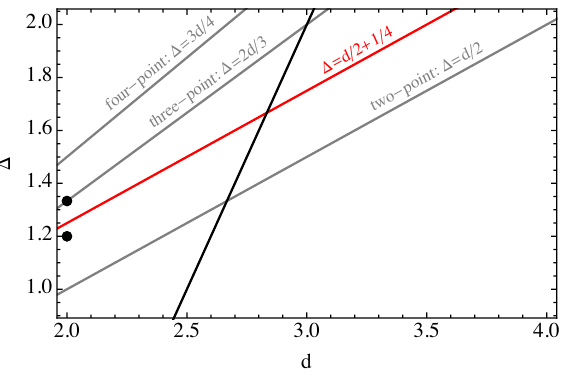
Figure 2 . In gray, the values of ∆( d ) for which the integrals of the two, three and four-point functions in (2.4)–(2.6) diverge at short distances. In red, the values for which we expect the four-point function to diverge when using a Hamiltonian Truncation cutoff: ∆ = d/ 2 + 1 / 4 . This threshold can be probed by, for example: minimal models M p , with p = 4 , 5 , perturbed by the primary operator φ 13 , whose dimension is ∆ = 6 / 5 , 4 / 3 respectively (black dots), and the free boson perturbed by φ 4 , which has dimension 2 d − 4 (black